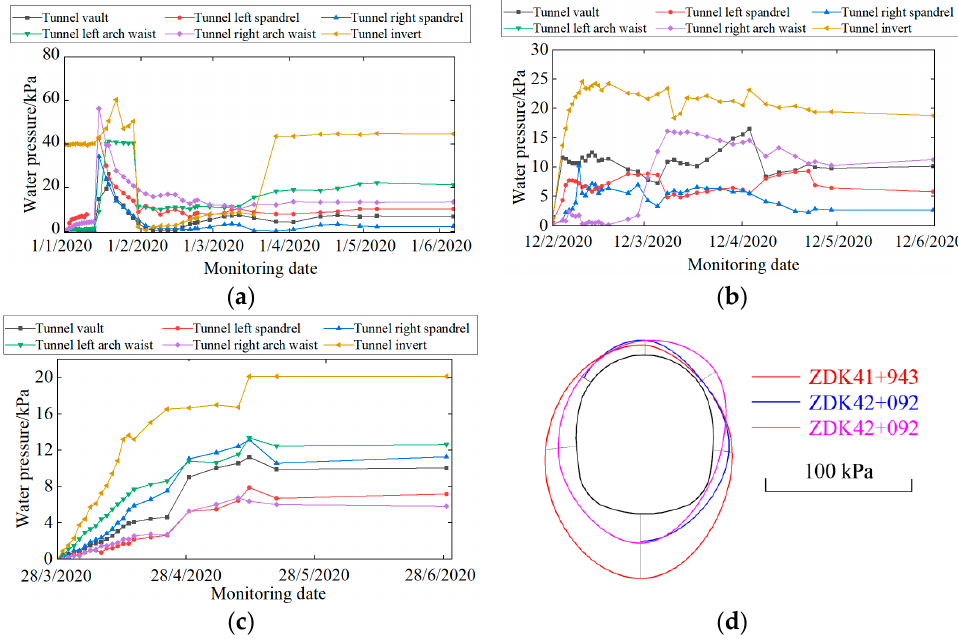
Figure 5. The initial support external water pressure: ( a ) the time ‐ history curve of water pressure of the monitoring section ZDK41+943; ( b ) the time ‐ history curve of water pressure of the monitoring section ZDK42+092; ( c ) the time ‐ history curve of water pressure of the monitoring section ZDK42+330; ( d ) the water pressure distribution along the section. (The dates are in the form of ʺ day / month ʺ .)